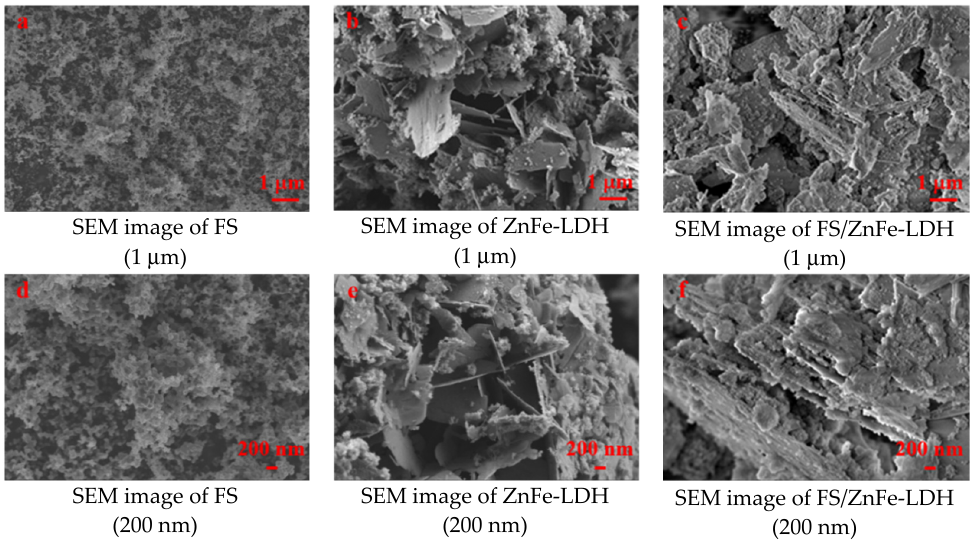
Figure 4. Scanning electron microscope(SEM) diagram of ZnFe-LDH, FS/ZnFe-LDH, and FS.From